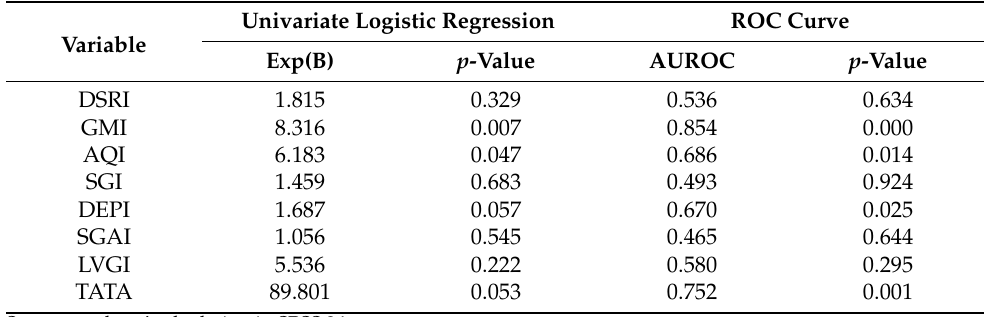
Table 3. Univariate binary logistic regression.